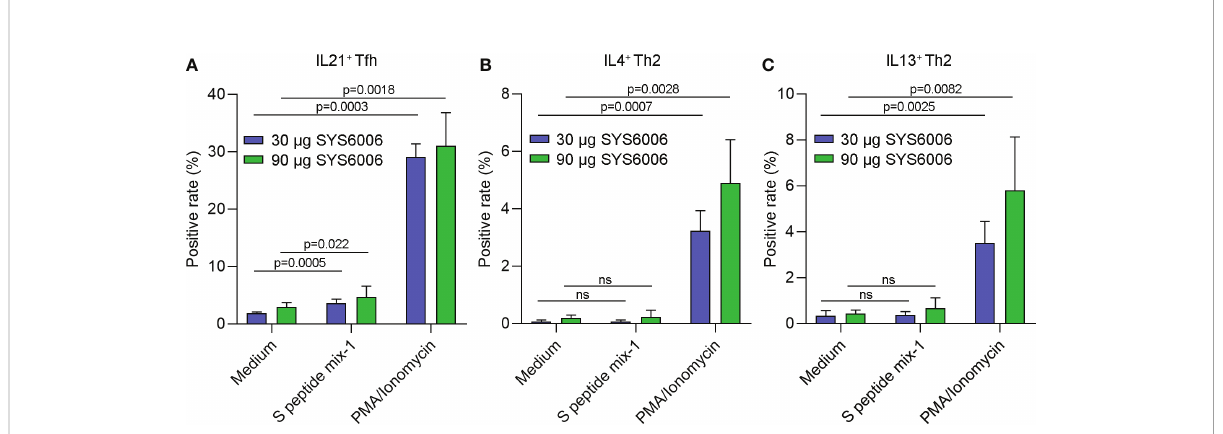
FIGURE 6 The antigen-speci fi c Tfh and Th2 cells in NHPs immunized with two different doses of SYS6006. Cynomolgus macaques were intramuscularly immunized with the indicated doses of SYS6006 and boosted with a 21-day interval using the same dose. The peripheral blood mononuclear cells were collected from NHPs 50 days after the 1 st vaccination, stimulated with a peptide pool of SARS-CoV-2 S protein, and tested for the rates of IL21 + Tfh cells (A) , and IL4 + (B) and IL13 + (C) Th2 cells via FACS analysis (n=3). Data are presented as mean ± SD. PMA/Ionomycin was positive control to stimulate T cells. ns, no signi fi cance; NHPs, non-human primates; Tfh, T follicular helper cell; PMA, phorbol 12-myristate 13- acetate.